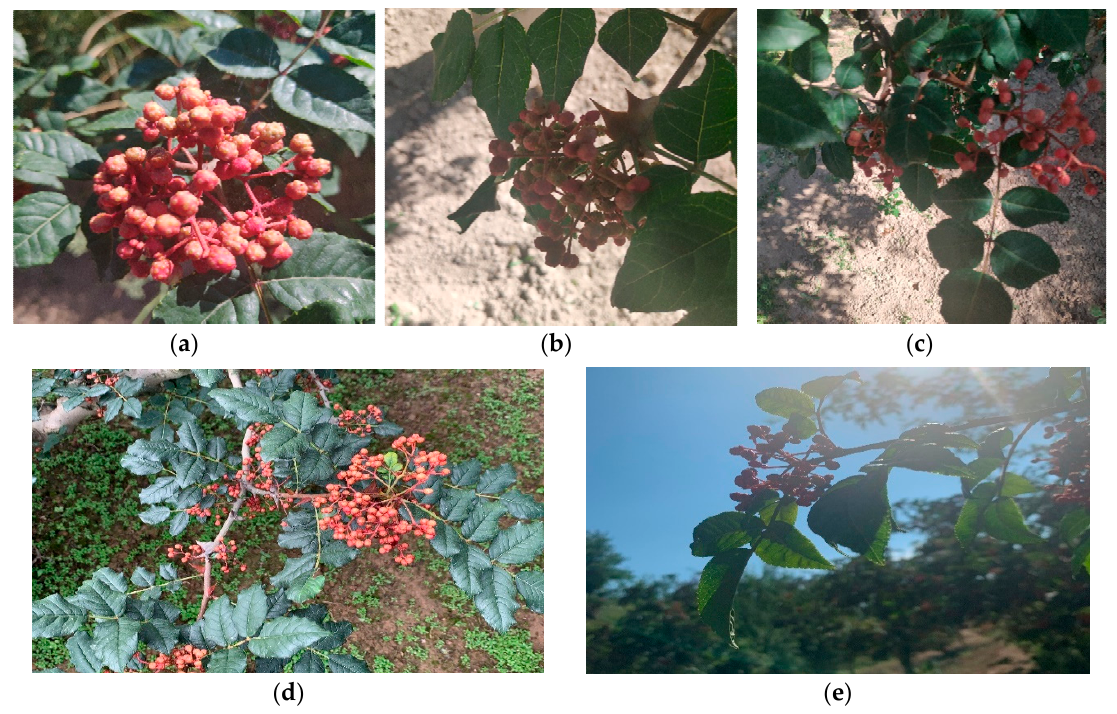
Figure 1. Images of Zanthoxylum under different conditions. ( a ) Single cluster of Zanthoxylum with smooth light and no shade; ( b ) Single cluster of Zanthoxylum with backlight; ( c ) Zanthoxylum with shade of leaves; ( d ) Clusters of Zanthoxylum with overlapping smooth fruits; ( e ) Clusters of Zanthoxylum with backlight.